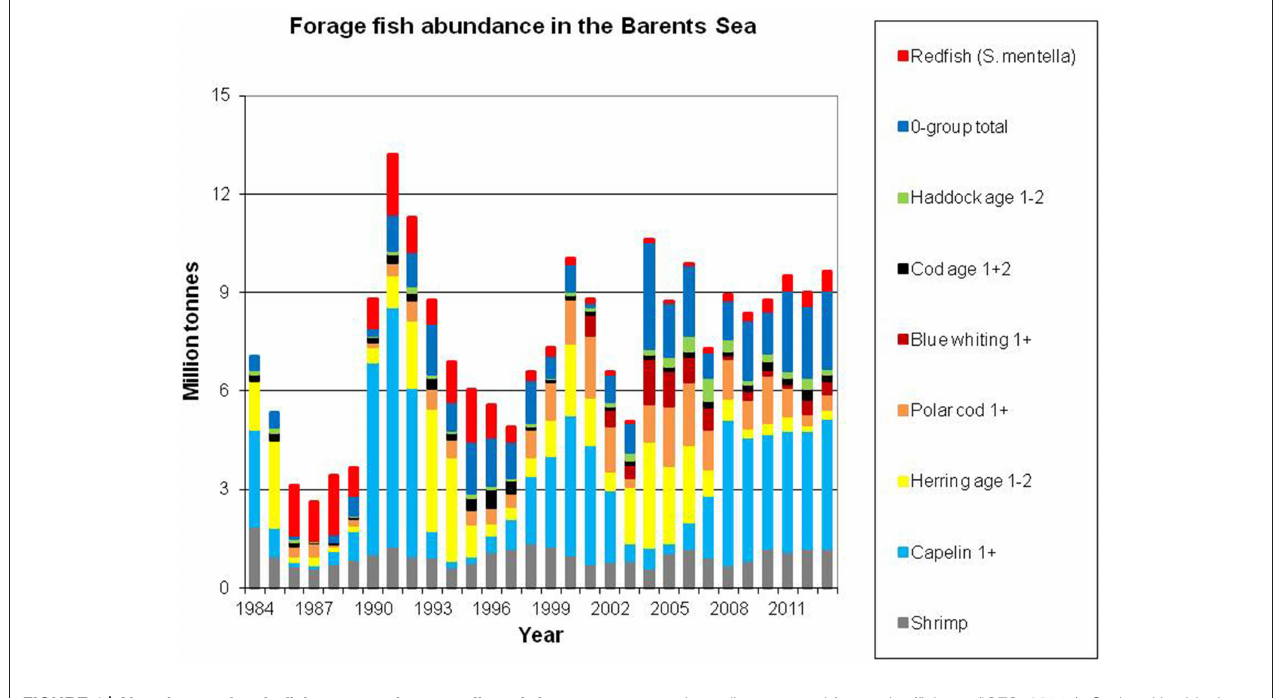
FIGURE 4 | Abundance of main fish prey stocks, as well as shrimp. Data sources: Capelin: acoustic estimates in September, age 1 + (ICES, 2014a); Herring: VPA biomass estimates of age 1 and 2 herring (ICES, 2014b ) using constant weights at age (10g for age 1 and 44g for age 2); Polar cod and blue whiting: acoustic estimates in September, age 1 + ( Prokhorova, 2013); 0–group: estimates of biomass of cod, haddock, herring